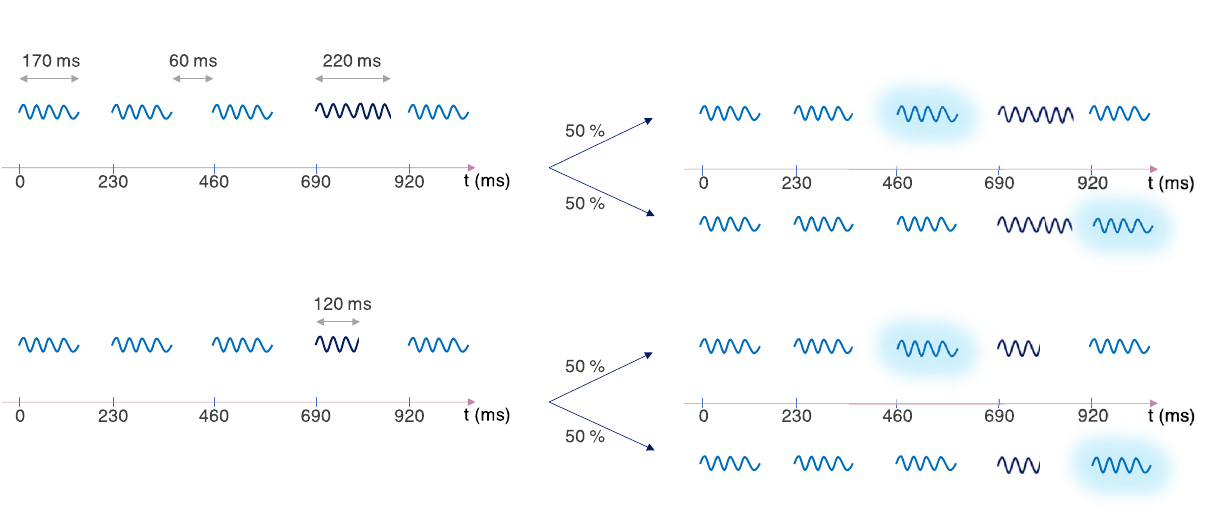
Figure 1. Stimuli without (left) and with (right) a singleton (surrounded with a glow), with 50% chances being before or after the target (dark blue). Only sequences with target in position 4 are shown